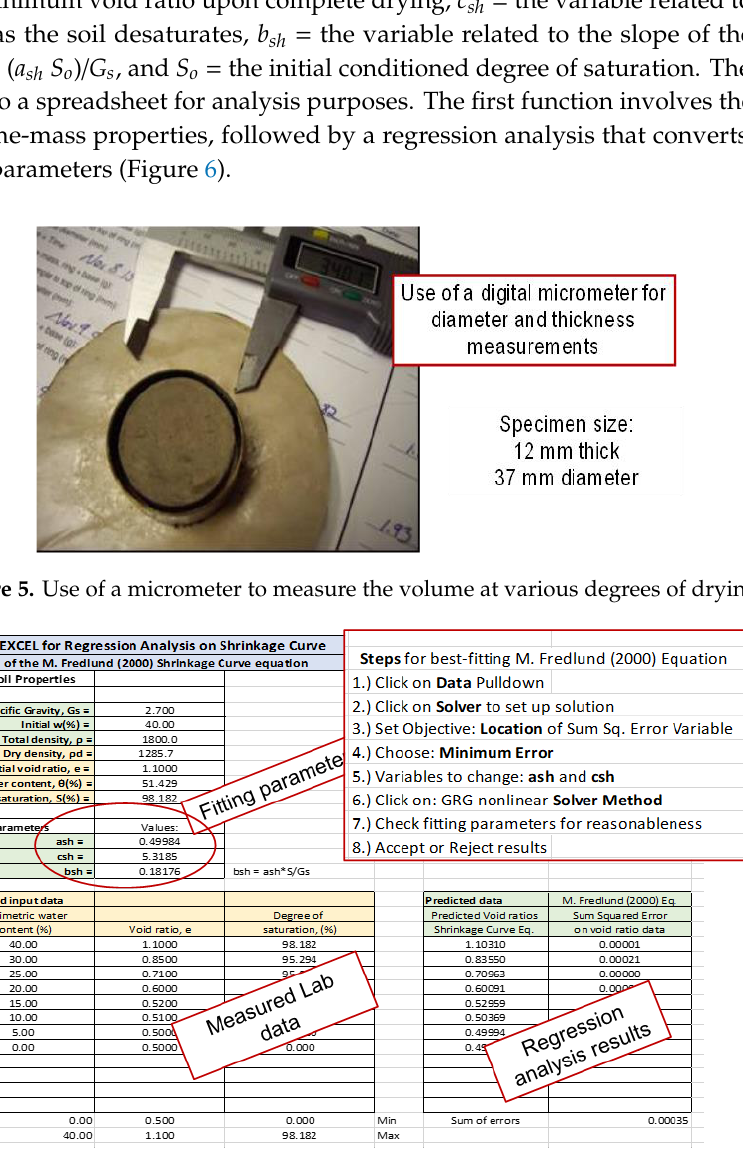
Figure 6. EXCEL Spreadsheet used for regression analysis of SC laboratory data.